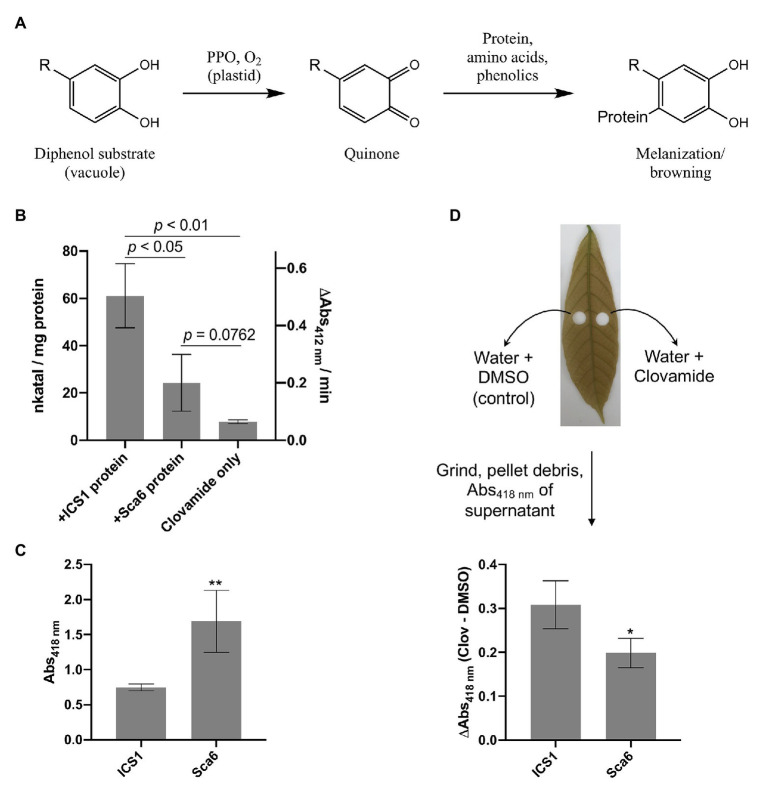
Clovamide’s contribution to enzymatic browning as a polyphenol oxidase (PPO) substrate. (A) Diagram of PPO-mediated formation of quinones from generic o-diphenol substrate and subsequent melanization/browning. Adapted from Yamane et al. (2010). (B) PPO activity (quinone formation) of ‘ICS1’ and ‘Sca6’ stage C leaf protein extracts with clovamide as substrate. [Clovamide] = 0.5 mM in all treatments shown. p-values from t-test, n = 3. (C) Browning in supernatant (Abs418 nm) of ground stage C leaf disks in water (**
p < 0.01, n = 4). (D) Enhanced browning in supernatant (ΔAbs418 nm) by addition of clovamide (~27.7 μg clovamide added per leaf disk, see methods; *
p < 0.05, n = 4). Clov = clovamide. Error bars in (B–D) represent standard deviation.